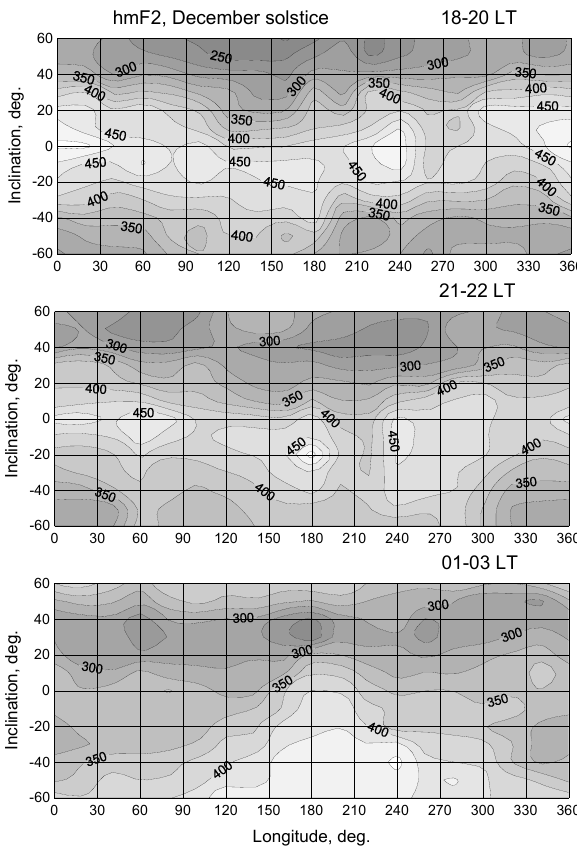
Fig. 4 to the manuscript by G.F. Deminova "Maps of foF2, hmF2, ..."